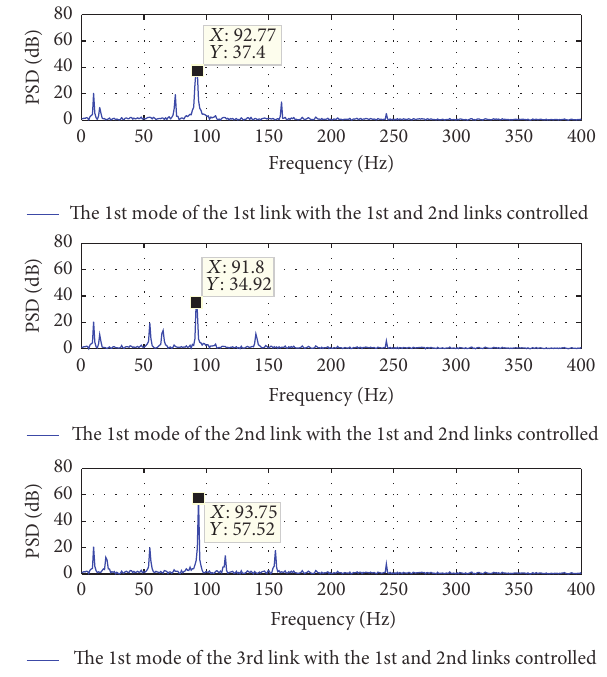
Figure 18: The PSD plot of the first mode of the three links under the third